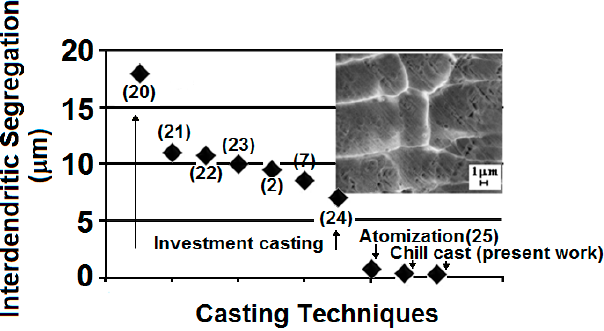
Figure 4. Interdendritic segregation reported in Co ‐ alloys. References are given in parentheses and the chill cast corresponds to the present work.